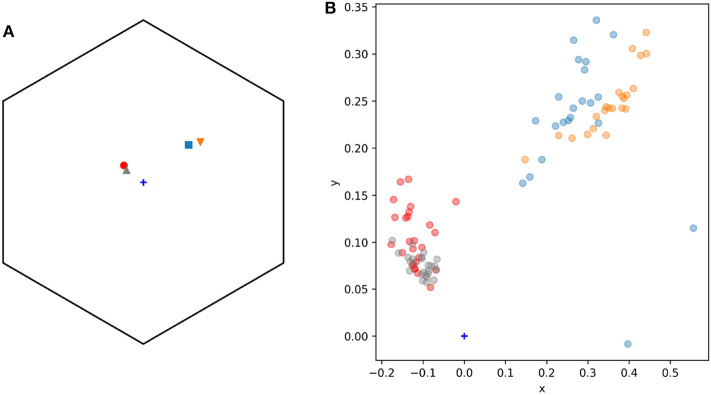
General view (A) and detail (B) of the n = 95 spectral samples used to model adaxial lateral petals (n = 25, triangular markers) and labella (n = 22, inverted triangles) of the mimic orchid Eulophia zeyheriana, and adaxial petals (n = 26, circle markers) and pollen (n = 22, square markers) of the rewarding species Wahlenbergia cuspidata. (B) Shows a detail of (A) highlighting color variability in sampled regions. Marker colors were selected to ease visualization: gray (lateral petals E. zeyheriana), red (petals W. cuspidata), orange (labella E. zeyheriana), and blue (pollen W. cuspidata). Color space's center is indicated by a blue cross marker.